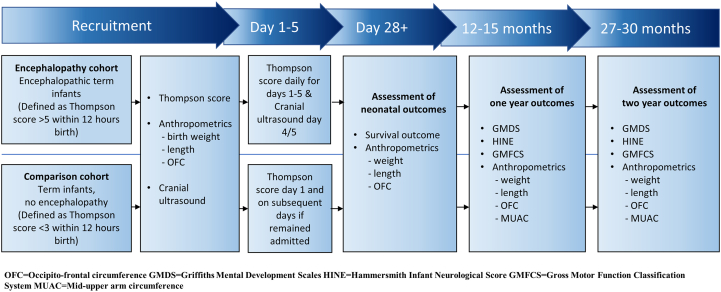
Diagram showing how participants moved through the study.